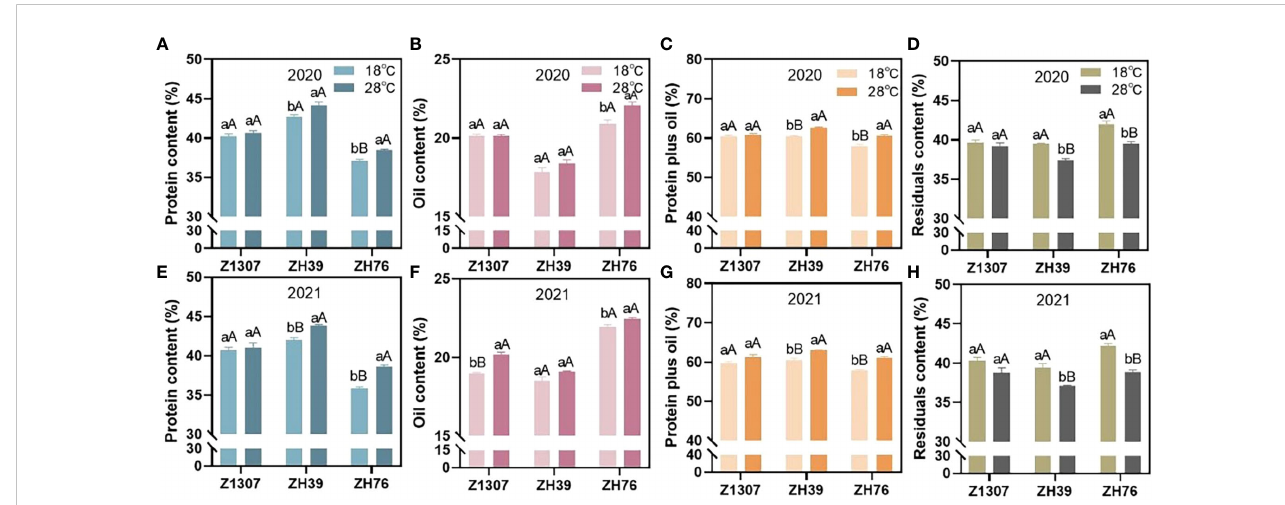
FIGURE 1 Effect of high night temperature on protein, oil, protein plus oil and residual contents in mature soybean seeds. The soybean seed protein (A-2020, E- 2021), oil (B-2020, F-2021), protein plus oil content (C-2020, G-2021) and residual (D-2020, H-2021) contents of the three varieties Z1307, ZH39 and ZH76 under 18°C and 28°C night temperature during seed- fi lling stage were showed in the fi gure. The different letters indicate signi fi cant difference at 0.05 level (small letter) and 0.01 level (big